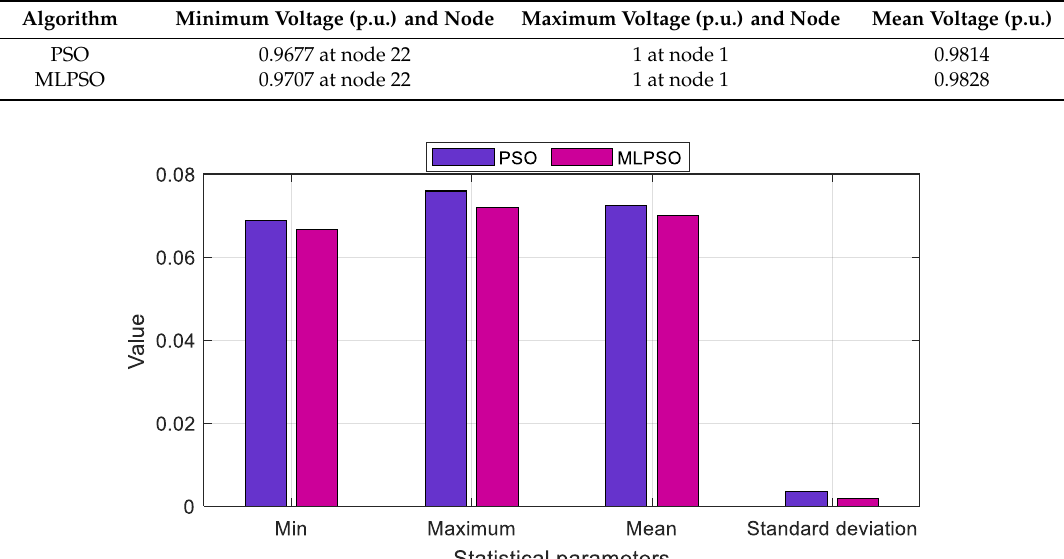
Figure 12. Variation of statistical parameters of PSO variants for the Malaysian bus system.